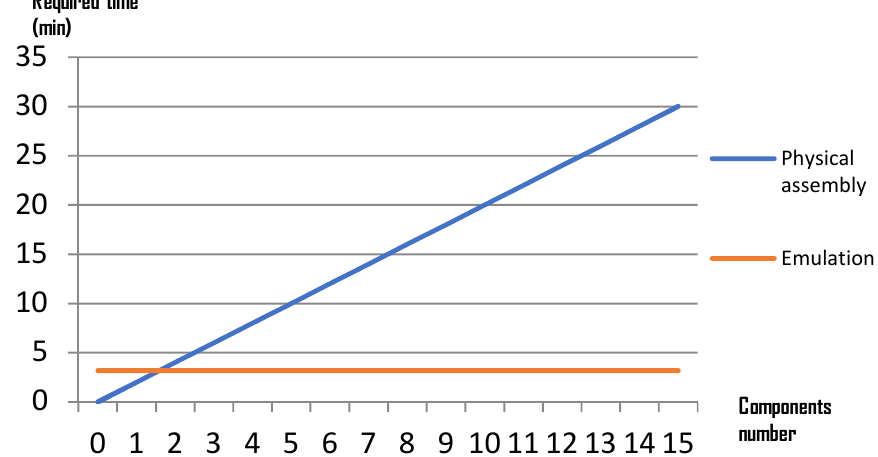
Figure 14. Required extrapolated time comparing the physical assembly of the circuit (classical lab practice) case and the board preparation for an emulated lab practice case.